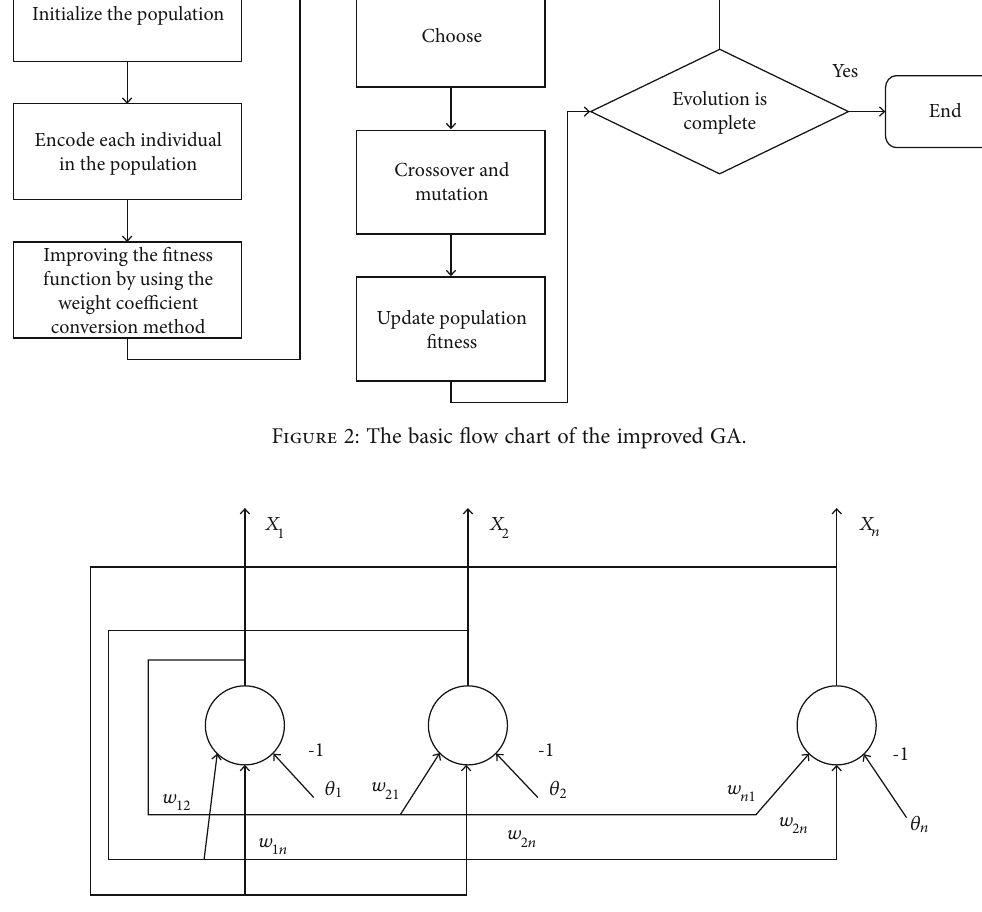
Figure 3: Schematic diagram of discrete